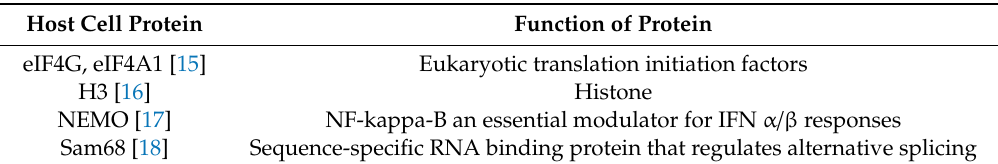
Table 1. Host-cell proteins cleaved by 3C pro